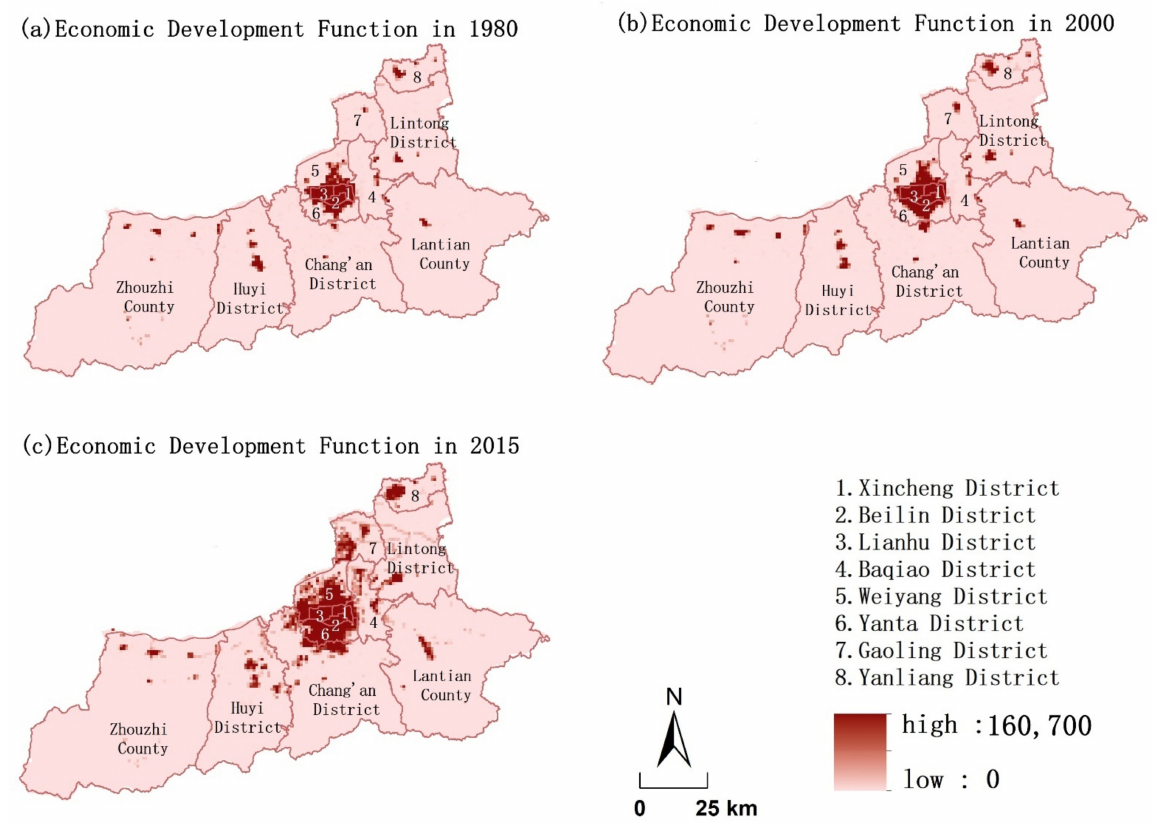
Figure 3. Spatial distribution of function of land system economic development in Xi’an from 1980 to 2015 (1 km × 1